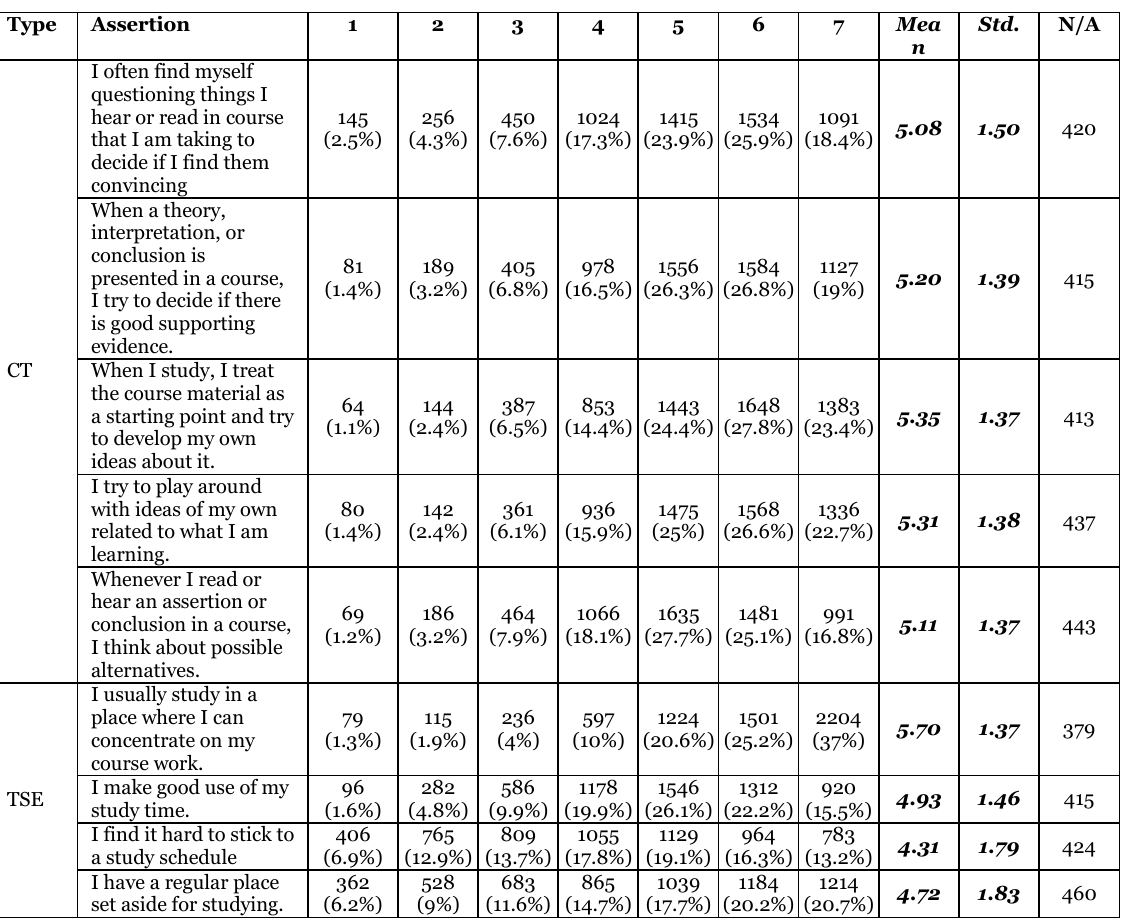
Learners’ Self-Reported Answers to Assertions on Learning